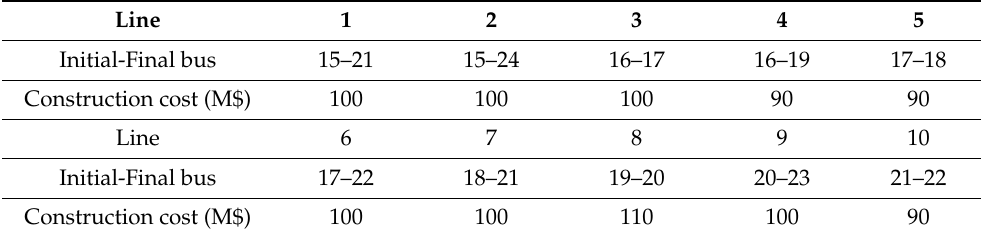
Table 8. The proposed line characteristics for construction.